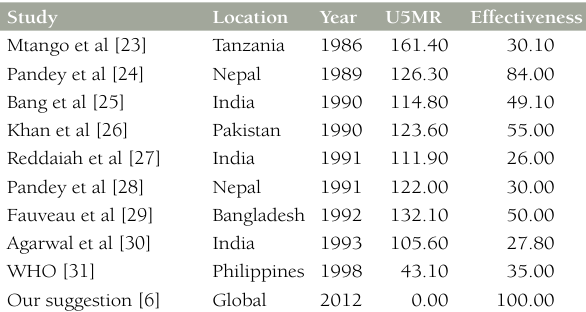
Table 2 Data for CCM effectiveness/Potential Impact